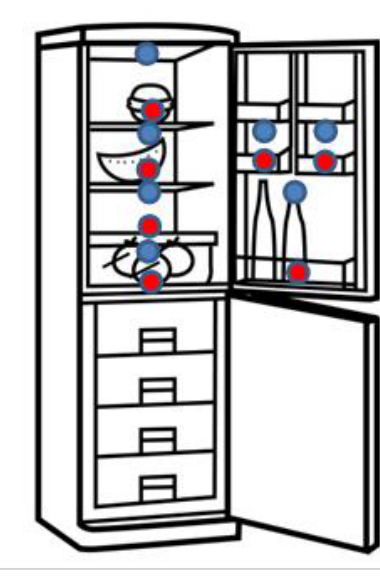
Figure 5. An example of a refrigerator with